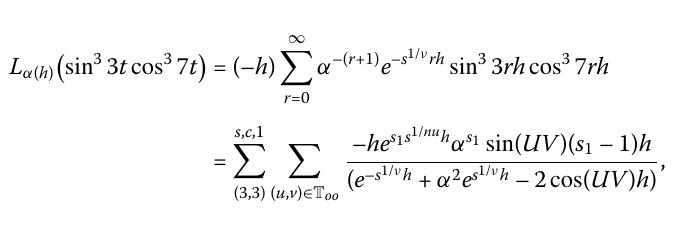
Example 5.2 Taking n 2 = 3, n 3 = 3, p = 3, and q = 7 in Theorem 5.1, we